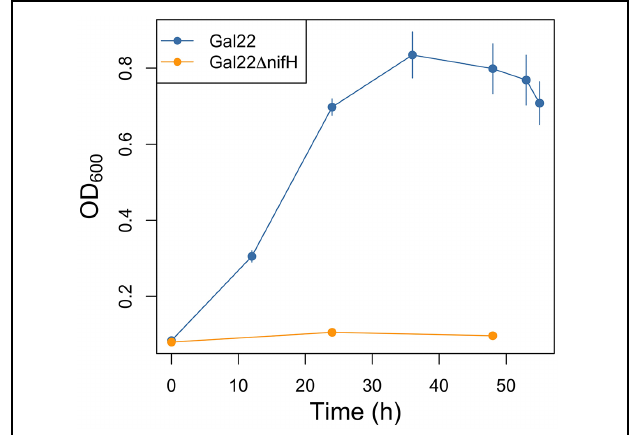
FIGURE 1 | Growthcurve of Gal22 wild type and mutant Gal22 (cid:2) nifH in nitrogen-free HGB medium and 1% O 2 in headspace